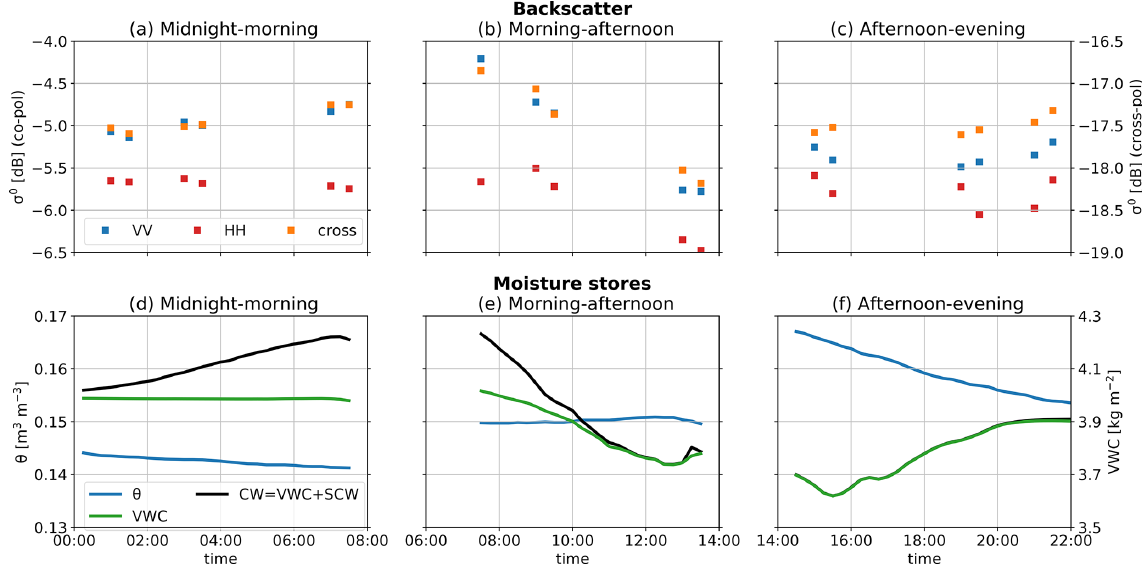
Figure 11. Backscatter (VV-, HH-, and cross-pol) and moisture (VWC, CW, and θ ) data aggregated across multiple days and separated by part of the day, i.e. midnight–morning, morning–afternoon, and afternoon–midnight. Periods with disturbing rain events are excluded, which means that data in panels (a, d) , (b, e) , and (c, f) are aggregated across 9, 6, and 4d, respectively. Canopy water (CW) is SCW displayed on top of